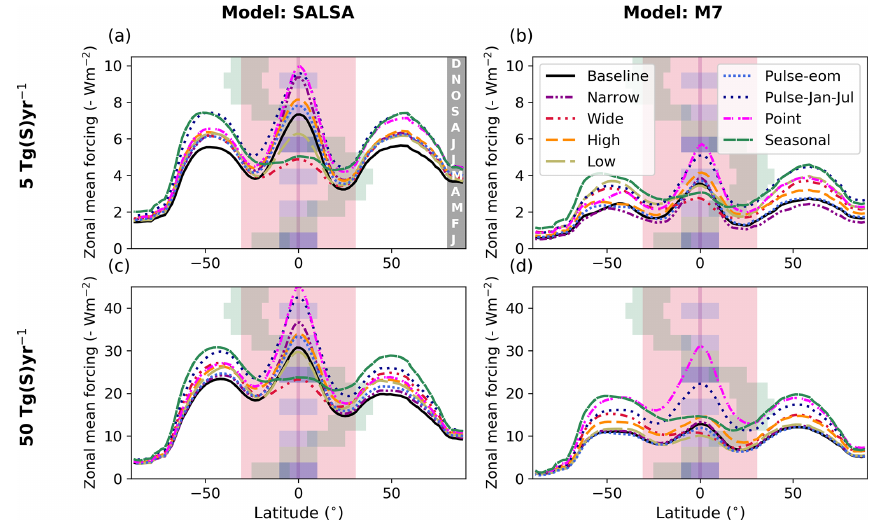
Figure 8. Zonal mean clear-sky net forcing with (a,b) 5 and (c,d) 50Tg(S)yr − 1 injection rates in simulated sensitivity scenarios. SALSA results are shown in panels (a) and (c) , and M7 results are shown in panels (b) and (d) . Note that the y axes show negative (cooling) values. Shaded areas show the latitudes of the injection area at the time of year (month shown on the right y axes of panel a ) for each injection scenario. Latitudes of the injection area are the same in the Baseline , High and Low scenarios (10 ◦ N–10 ◦